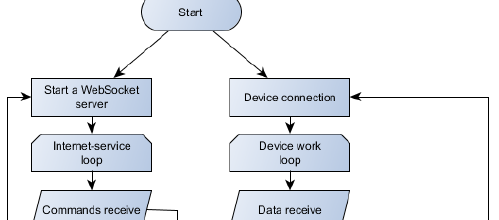
Fig. 13. PLCs program algorithm.